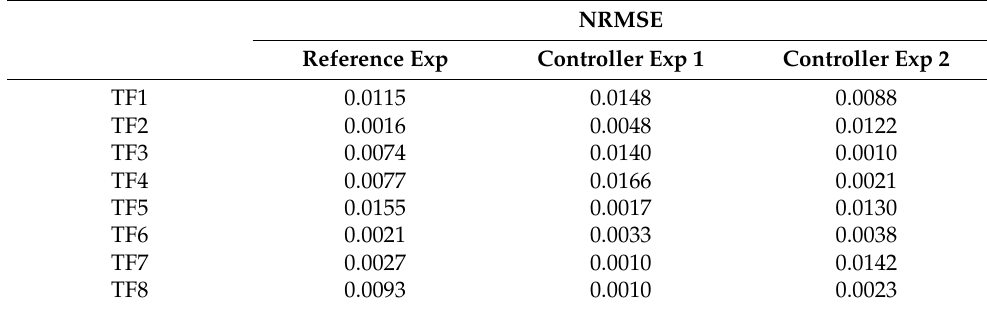
Table 7. NRMSE, model evaluation of the DARX [1 1 1] model for the data of all eight tissue flasks for all three experiments. A NRMSE equal to zero represents a perfect fit of the DARX model when compared to the experimental data.